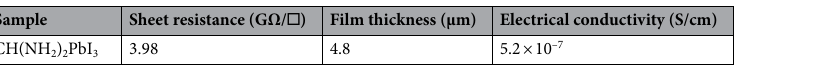
Table 1. Electrical properties of CH(NH 2 ) 2 PbI 3 nanostructures deposited by AACVD on glass substrate at 150 °C.